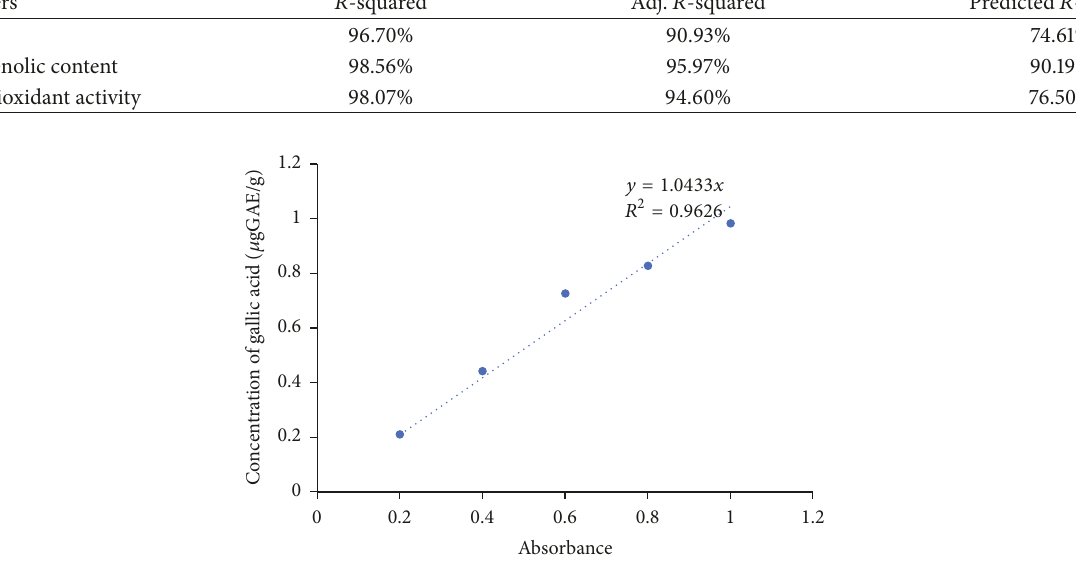
Figure 1: Standard curve for determination of phenolic